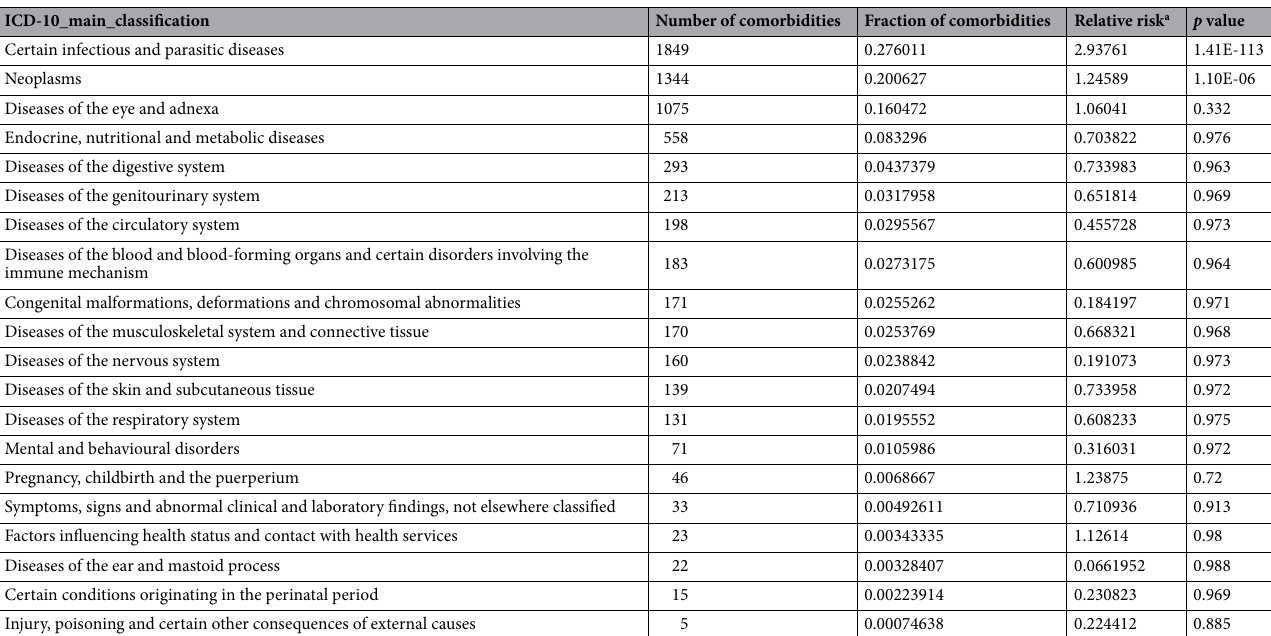
Table 2. Comorbidities of 20 ICD-10 main classifications for bacteria. a See text for